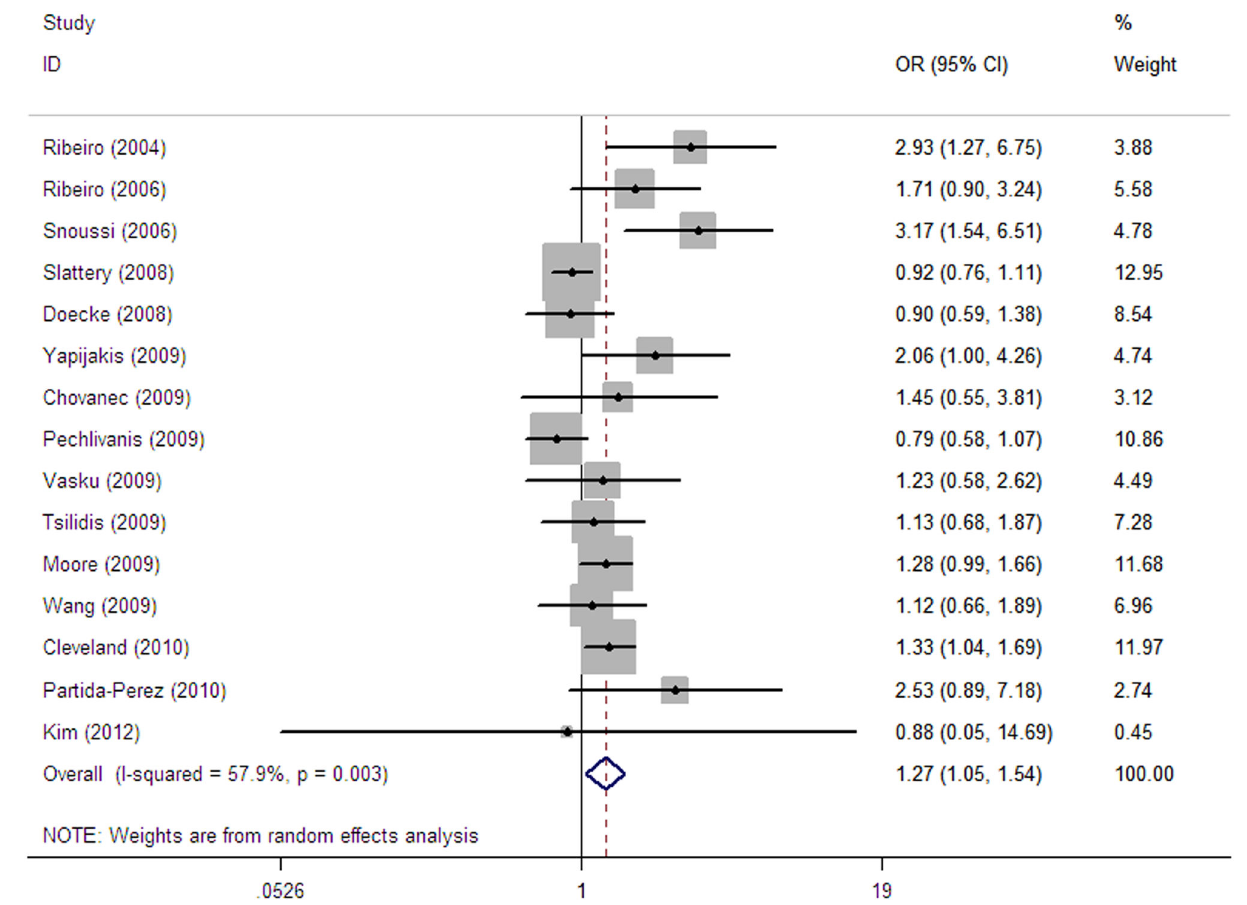
Figure 3. Forest plot for AA vs. GG of LEP G2548A polymorphism.